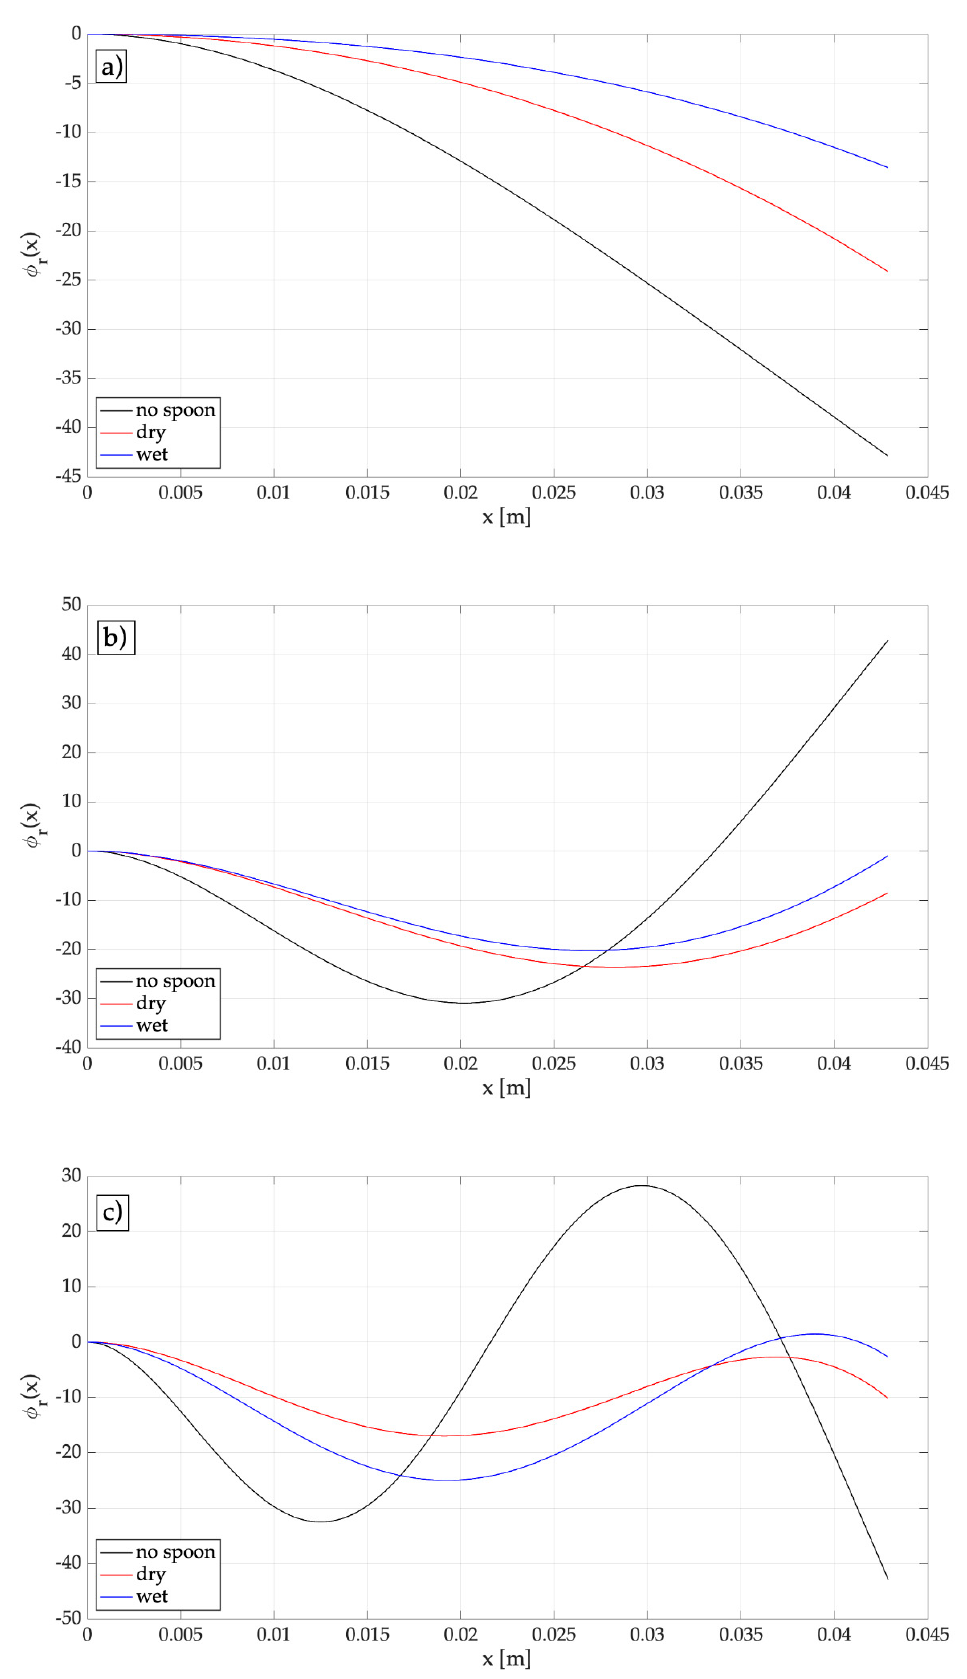
Figure 4. Mass-normalized modes of vibration: ( a ) First-order, ( b ) second-order, ( c ) third-order; dry: empty spoon, wet: filled with